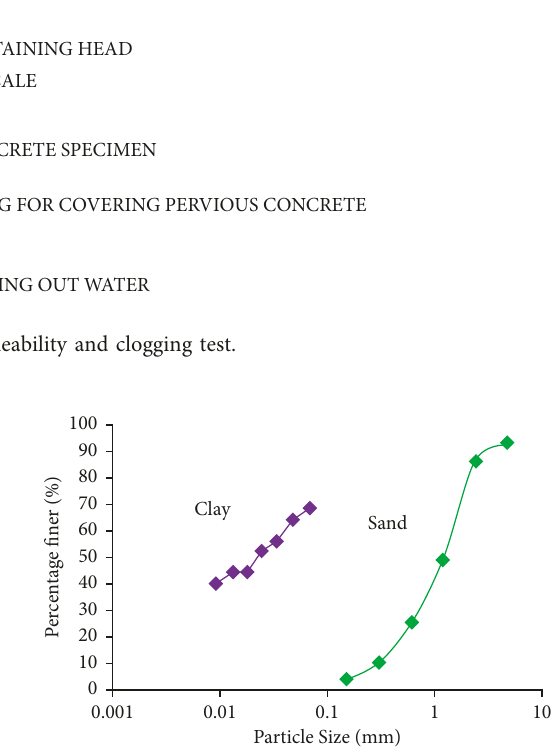
Figure 2: Grain size distribution of clogging material—clay and